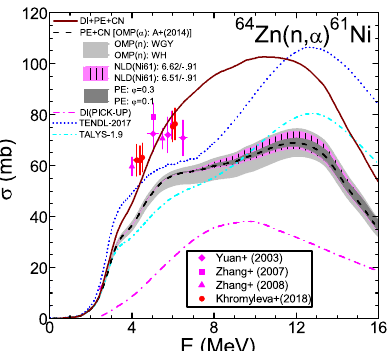
Figure 6. As Fig. 5 but for 64 Zn( n ,α ) 61 Ni reaction, except addi- tional DI component (dash-dotted) of total cross sections (solid).